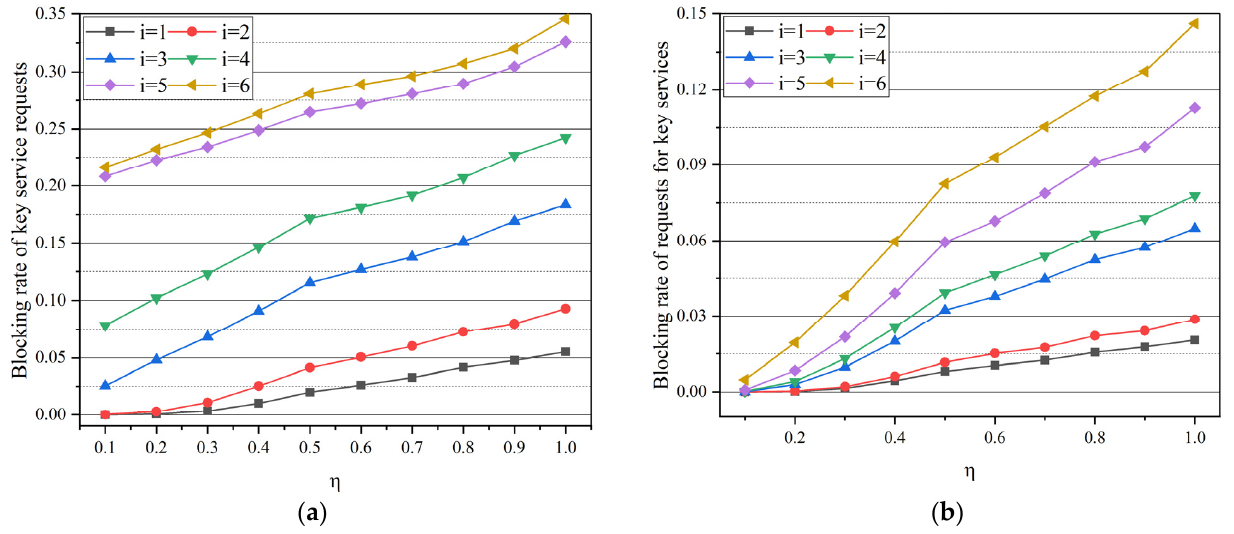
Figure 6. Simulation results: ( a ) blocking rate of key service requests varies with η in the case of different untrusted node numbers in NSFNET; ( b ) blocking rate of key service requests varies with η in the case of different untrusted node numbers in USNET.